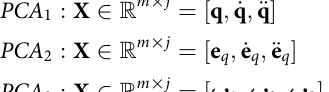
FIGURE 6 | PCA results comparison between input ( PCA 1 ), lack-of-fit residuals ( PCA 2 ) and a random signal ( PCA 3 ) for fourier